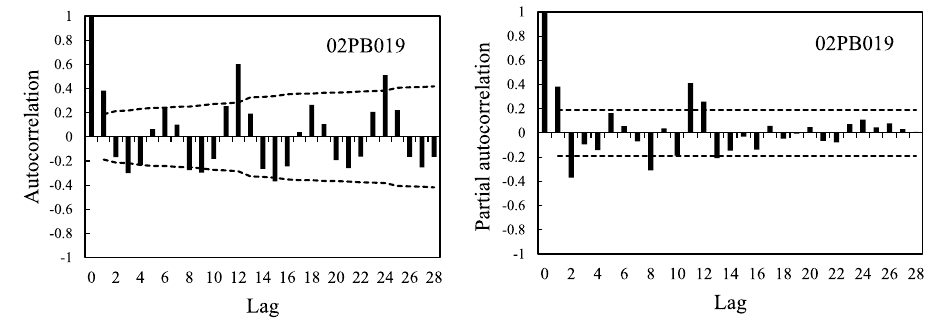
Fig. 4 ACF and PACF plots for station 02PB019 and the original data in the calibration period